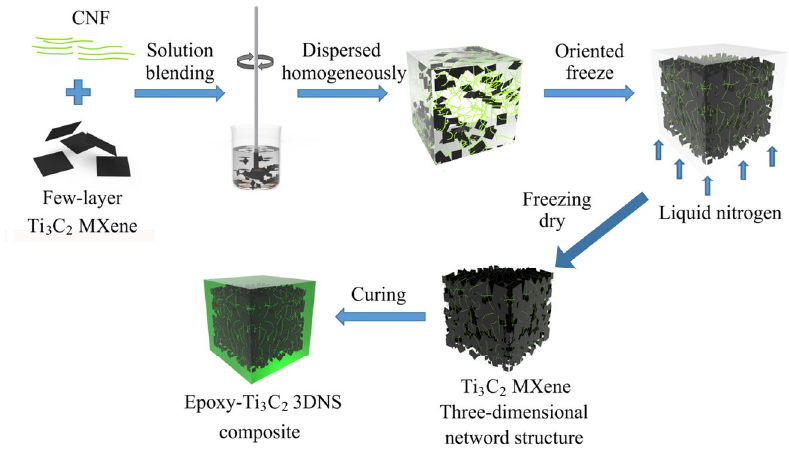
Fig. 1 Schematic diagram of preparation of epoxy–Ti 3 C 2 3DNS